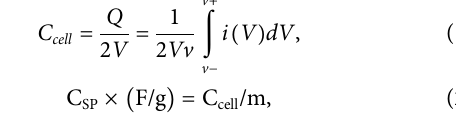
Frontiers in Chemistry |